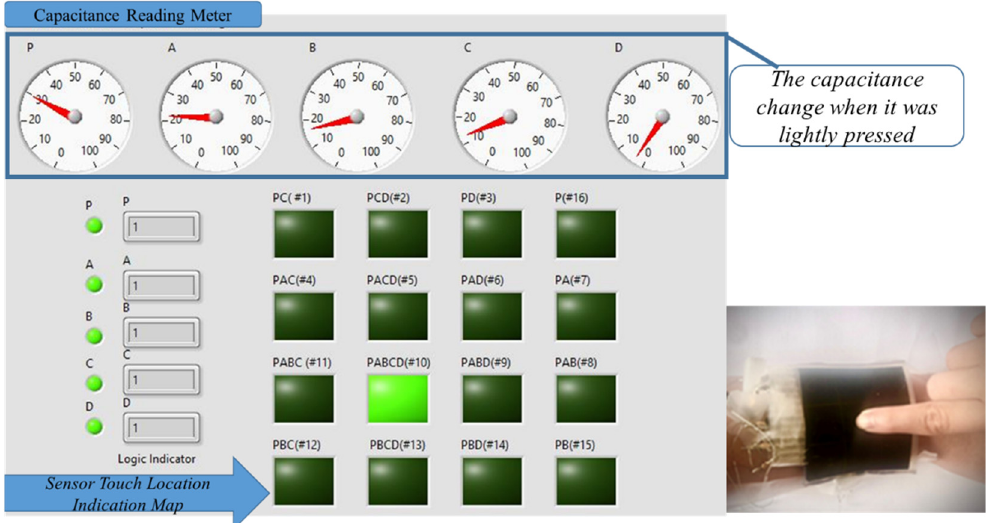
Figure 8. LabVIEW GUI readouts displaying multimodal sensor output in real-time when tactel # 10 was touched. The meter reads the capacitance change in the five sensors.